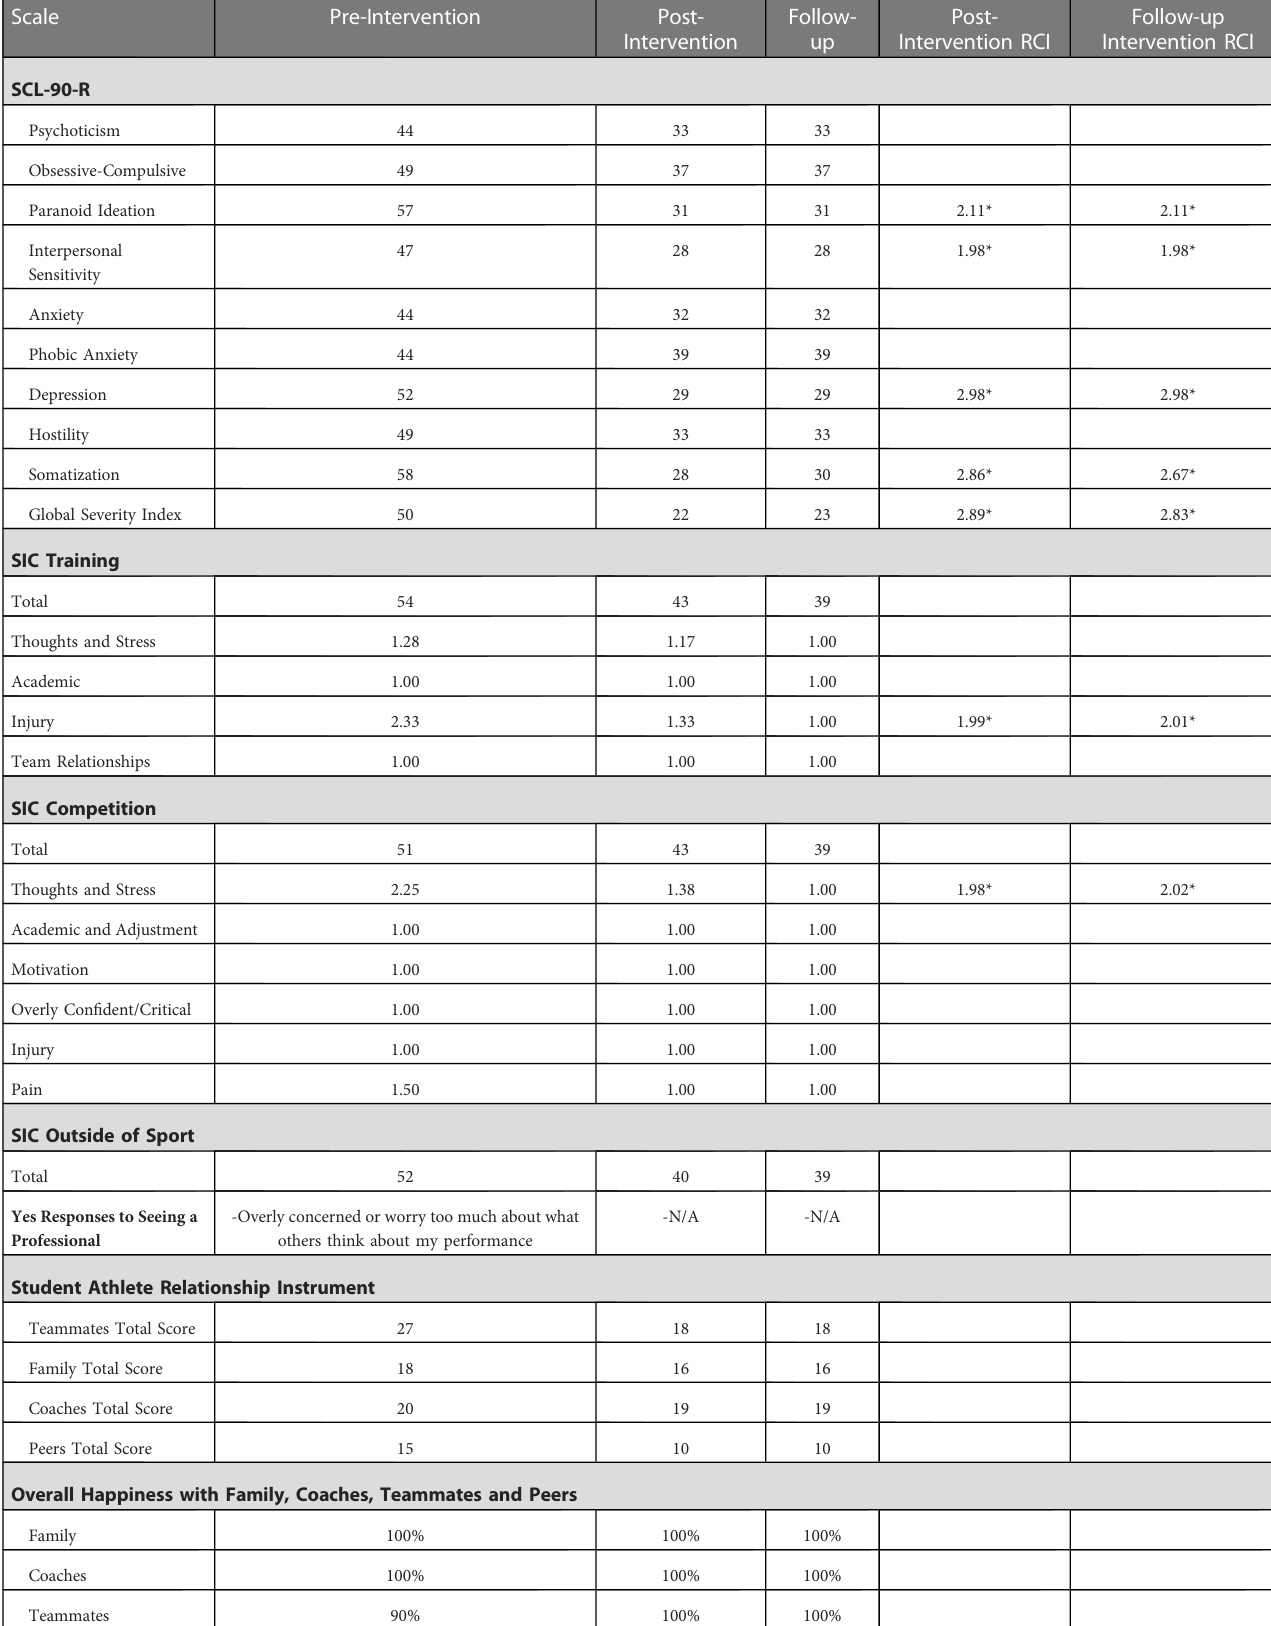
TABLE 1 Pre-, post- and follow-up assessments of mental health and factors interfering with sport